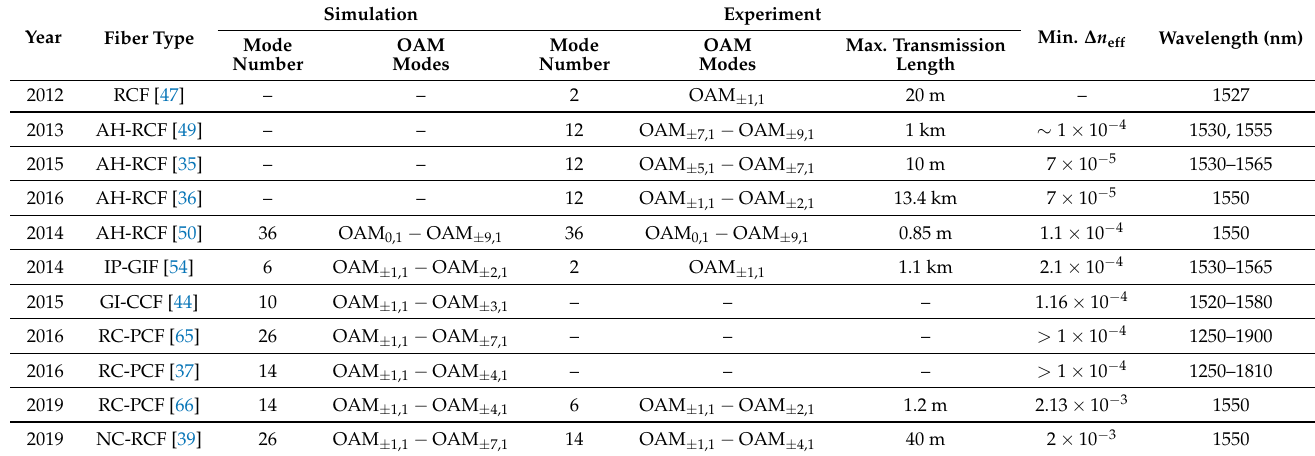
Table 1. Comparison among the reported fibers supporting OAM